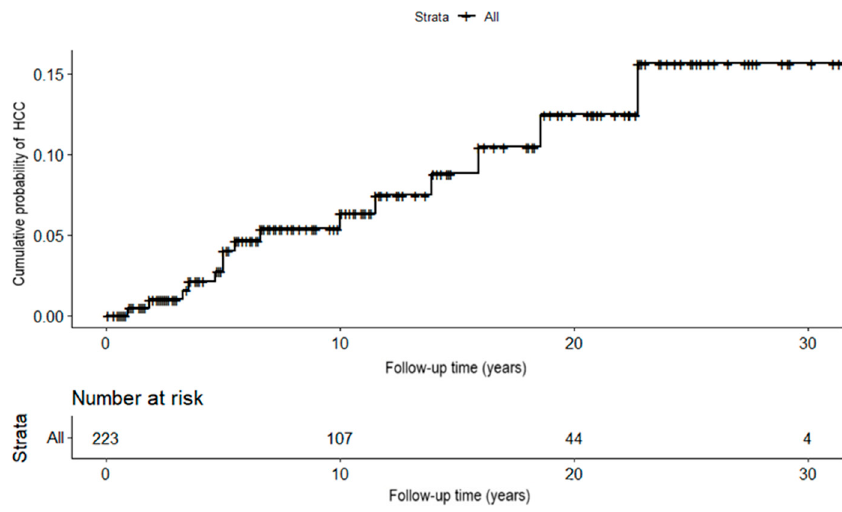
Figure 2. Cumulative incidence of hepatocellular carcinoma. HCC: hepatocellular carcinoma.